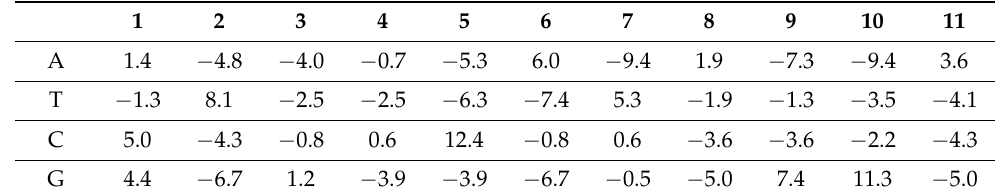
Table 3. Matrix mQ (11) for the TRs in the region from 2,630,589 to 2,630,061 nt of the first rice chromosome.